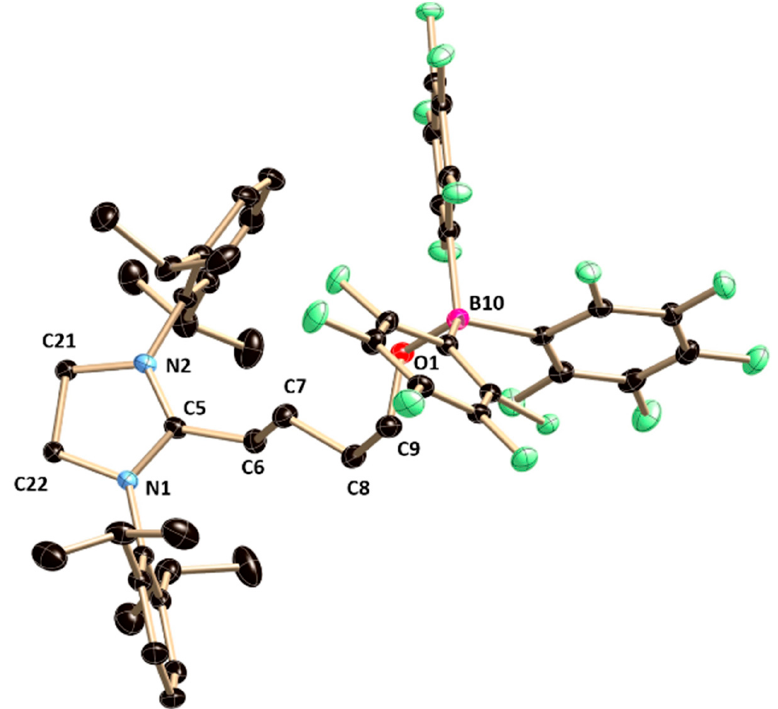
Figure 7. The molecular structure of 7 . Hydrogen atoms are omitted for clarity. Selected bond lengths [Å] or angles [deg]: N2–C5 1.322(2), N1–C5 1.327(2), N1–C22 1.479(2), N2–C21 1.484(2), C5–